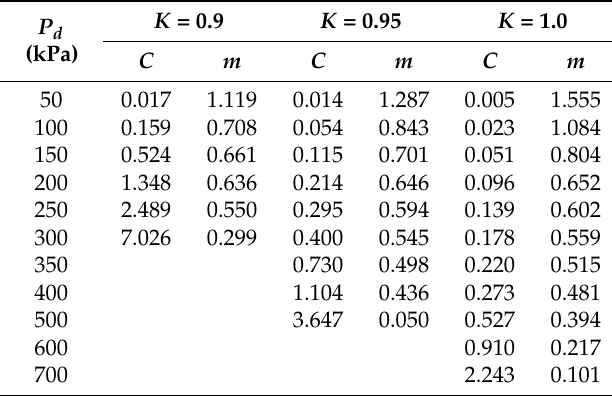
Table 3. The fitting value of C and m for the three models. K = 0.9 K = P d (kPa)